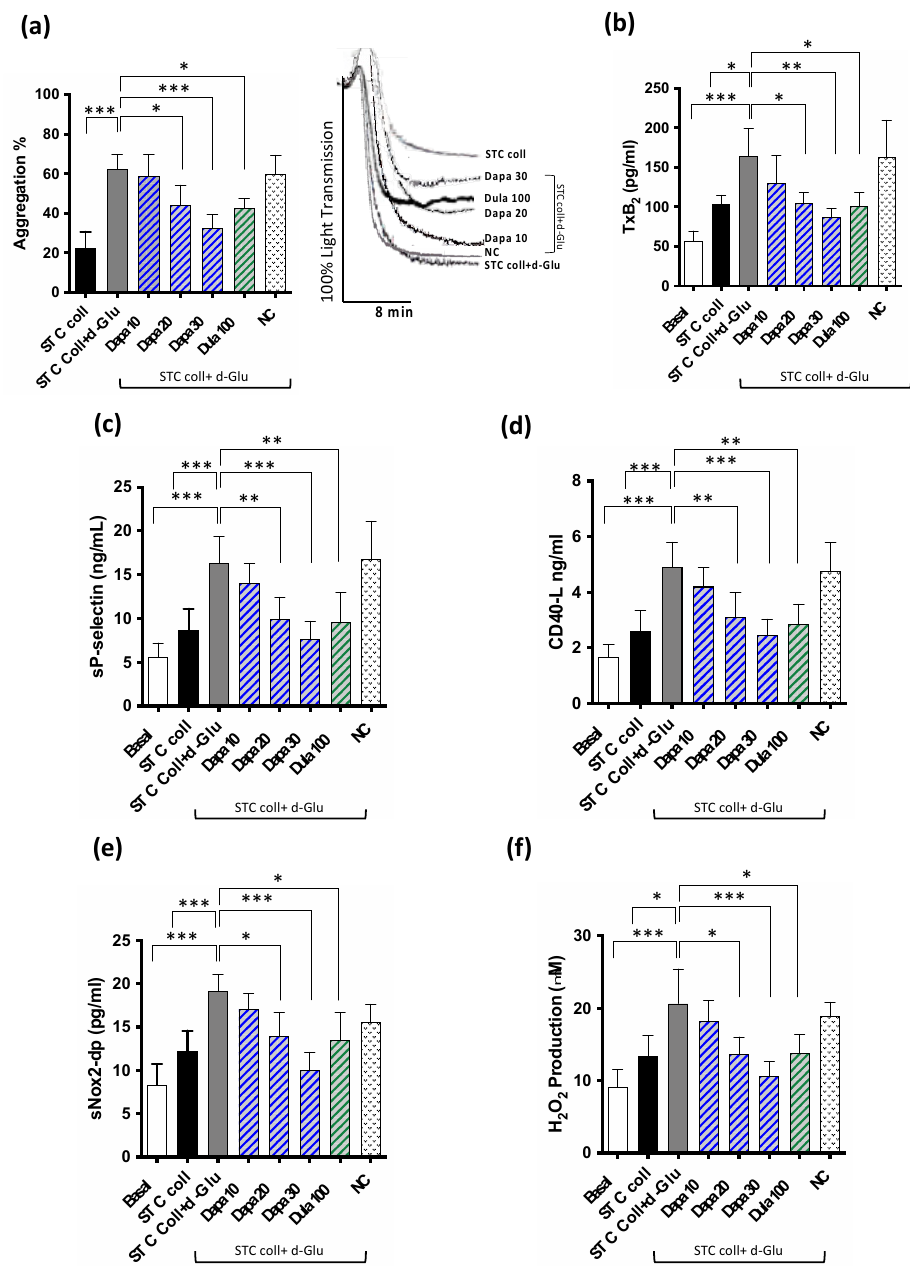
Figure 4. ( a ) Platelet aggregation and representative aggregometer trace, ( b ) Thromboxane B 2 production, ( c ) soluble P-selectin levels, ( d ) soluble CD 40 ligand, ( e ) serum soluble NOX2-derived peptide (sNOX2-dp), ( f ) serum H 2 O 2 in washed platelets (wPLTs) taken from HS ( n = 5) pre-incubated with or without d-Glucose (d-Glu, 10 mM) and then stimulated with or without STC of collagen (0.25 µ g/mL) in the presence or less of dapagliflozin (Dapa, 30 µ M) or dulaglutide (Dula, 100 nmol/L) or negative control (NC). Data were expressed as mean ± SD; * p < 0.05, ** p < 0.01; *** p <